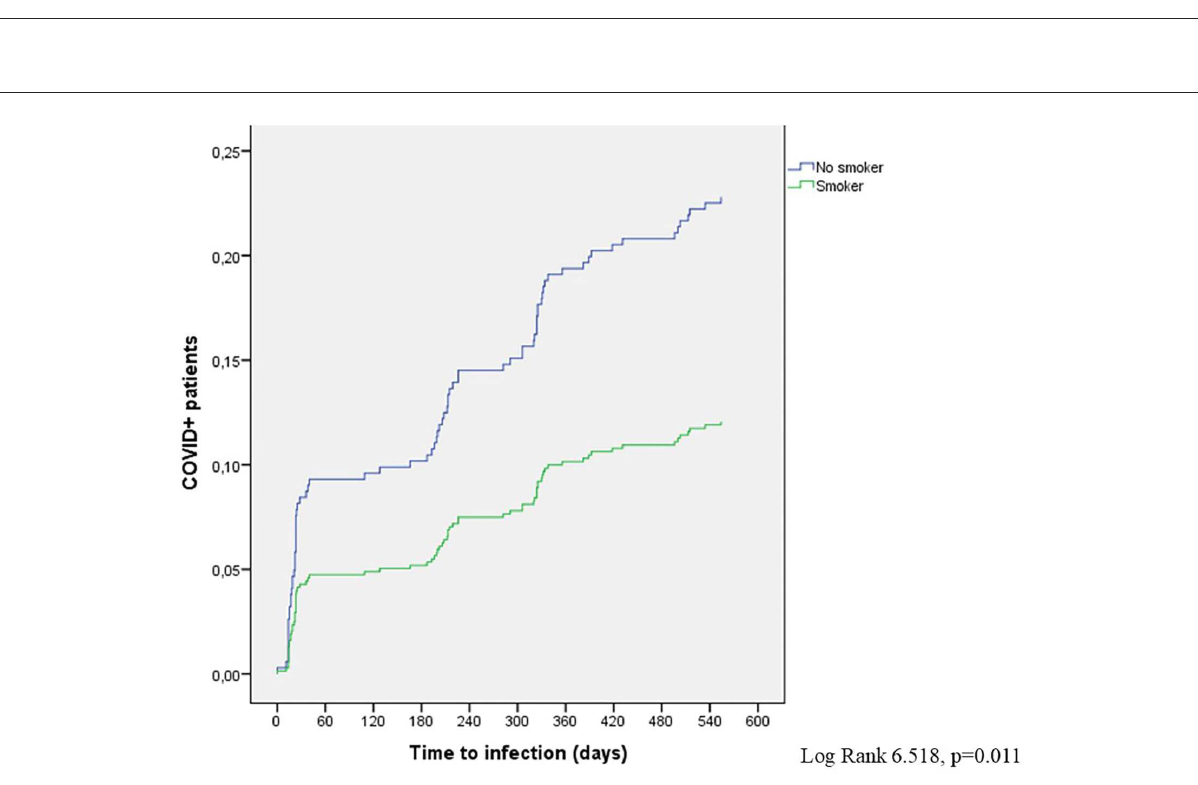
FIGURE5 COVID + patients in the smoker and non-smoker subgroups (Cox